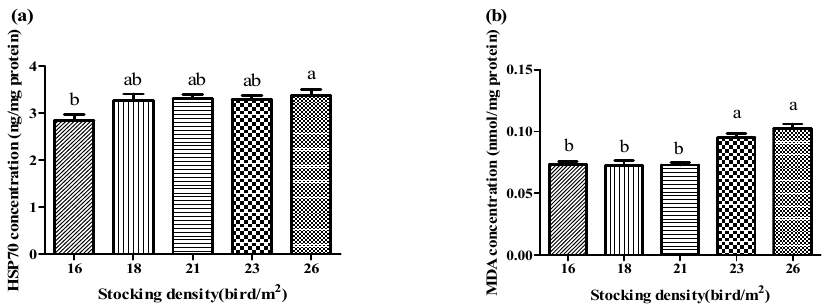
Figure 2. Effect of stocking density on heat shock protein 70 (HSP70) concentrations ( a ) and malondialdehyde (MDA) concentrations ( b ) in the livers of broiler chickens under high temperatures ( n = 15). HSP70: linear, p < 0.01; quadratic, p = 0.103. MDA: linear, p < 0.001; quadratic, p < 0.01. Bars with different letters (a,b) differ significantly across all groups ( p < 0.05).